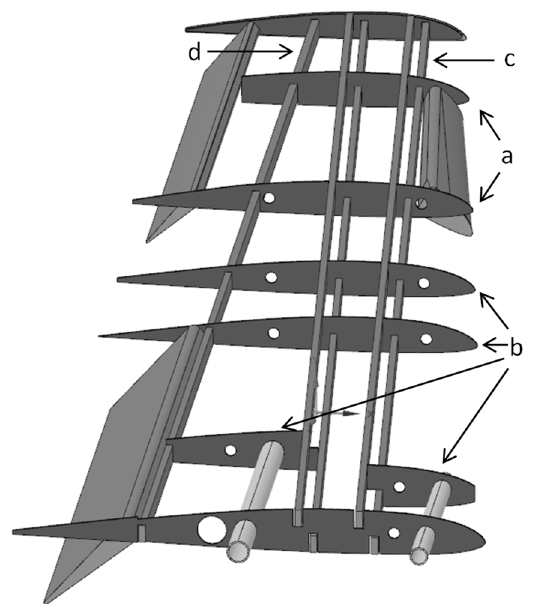
Figure 15. Adaptive wing prototype based on the S45 structure, spanwise view: ( a ) two actuators support ribs, ( b ) three skin support ribs, ( c ) front spar, and ( d ) rear spar.